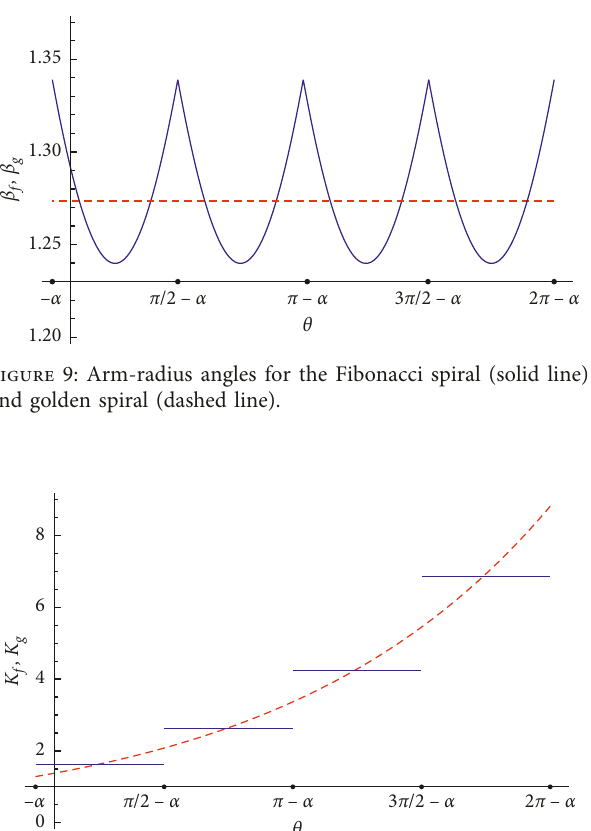
Figure 7: The difference of polar radii of the Fibonacci spiral and golden spiral ( a � 1).